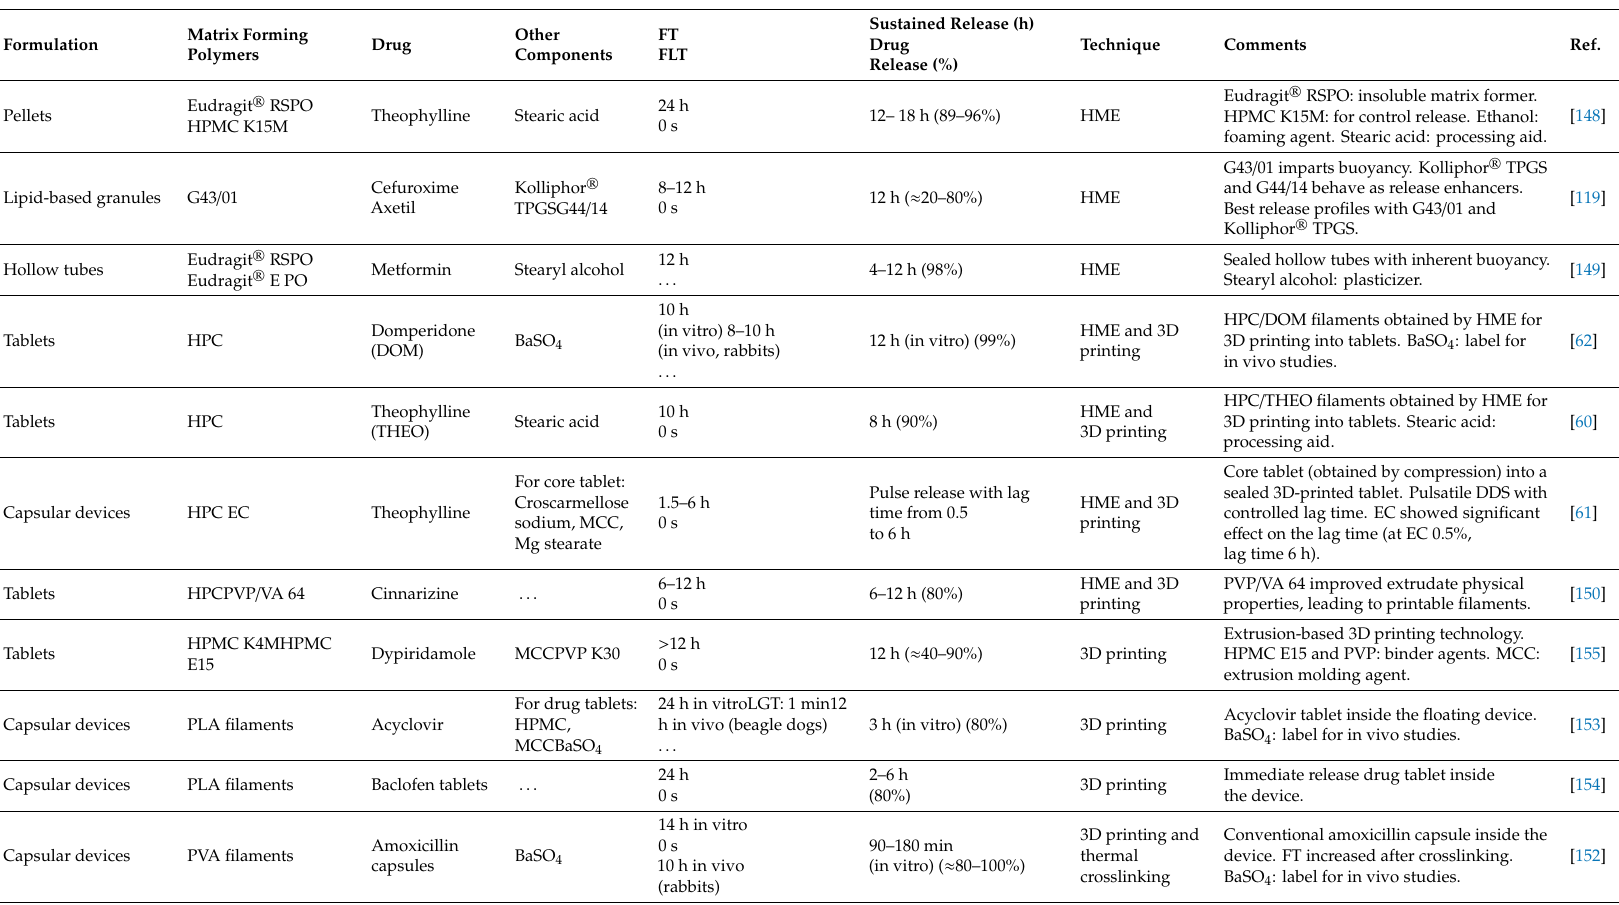
Table 8. Selected examples of floating gastroretentive drug delivery systems (GRDDSs) prepared by hot melt extrusion and / or 3D printing.